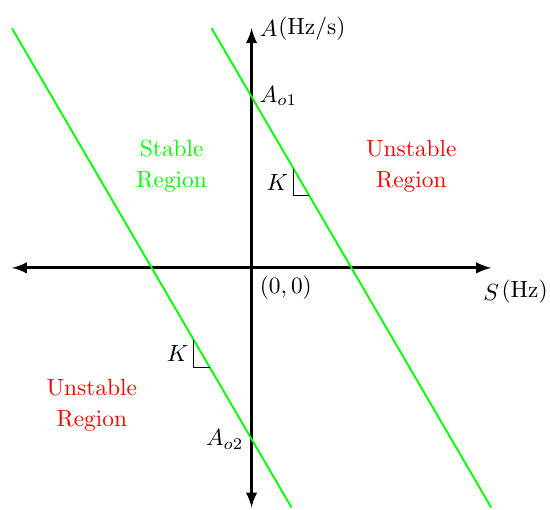
Figure 1. Out-of-step tripping (OOST) characteristic in the A − S